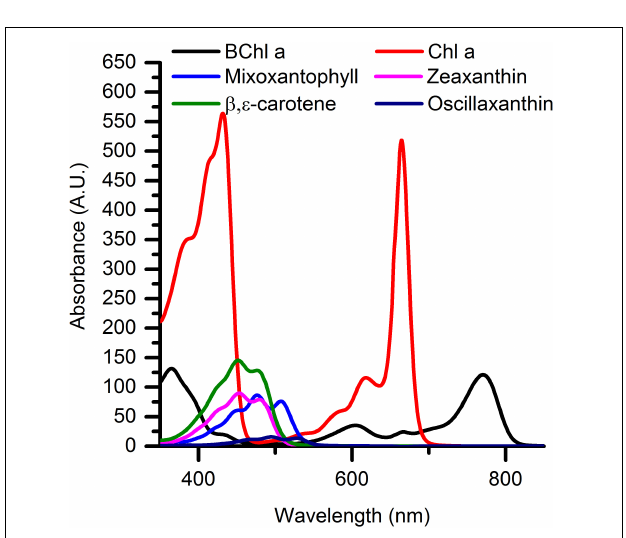
FIGURE 3 | Relative absorbance spectra of predominant photopigments found in the upper 0.5 mm of the microbial mat as investigated with HPLC